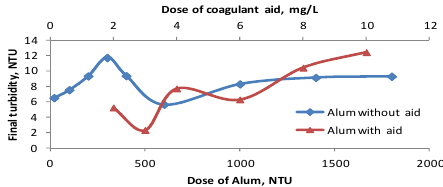
Fig.4.Effect of coagulant dose on removal of turbidity